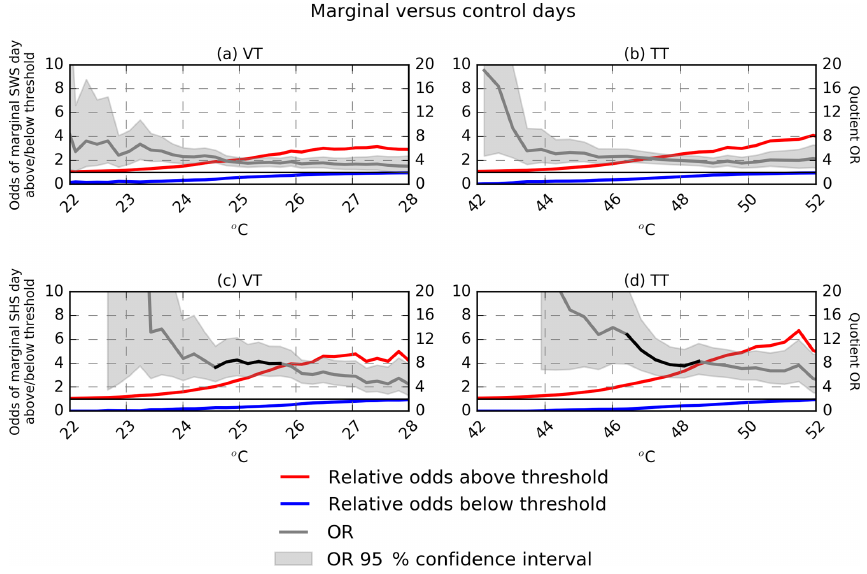
Figure 9. Same as Fig. 6a and b (a,b) and Fig. 8a and b (c,d) except that only marginal SWS and SHS days are used to calculate the OR. At very low and very high threshold values, the variance of the OR may be undefined, and the 95% OR confidence interval cannot be